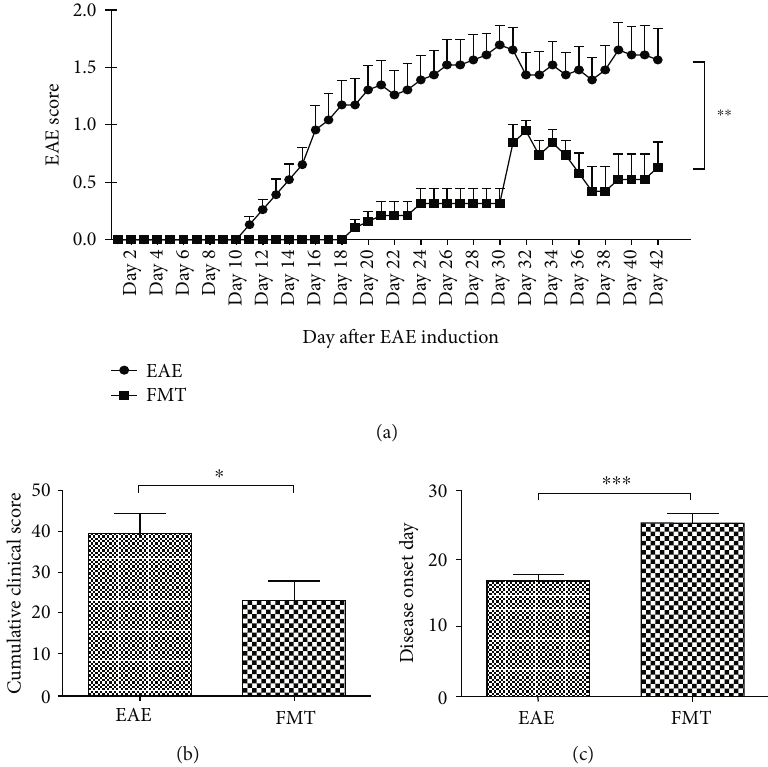
Figure 2: FMT has a therapeutic e ff ect on EAE. (a) Chart of clinical scores for EAE controls and FMT-treated immunized mice after EAE induction. FMT led to decreased clinical scores through the clinical course of EAE ( mean ± SEM ; n = 10 /group; ∗∗ p < 0 : 01 ). (b, c) Charts of cumulative clinical scores (b) and disease onset days (c) after EAE induction indicating reduced clinical severity and delayed disease onset after FMT treatment ( mean ± SEM ; n = 10 /group; ∗ p < 0 : 05 and ∗∗∗ p < 0 : 001